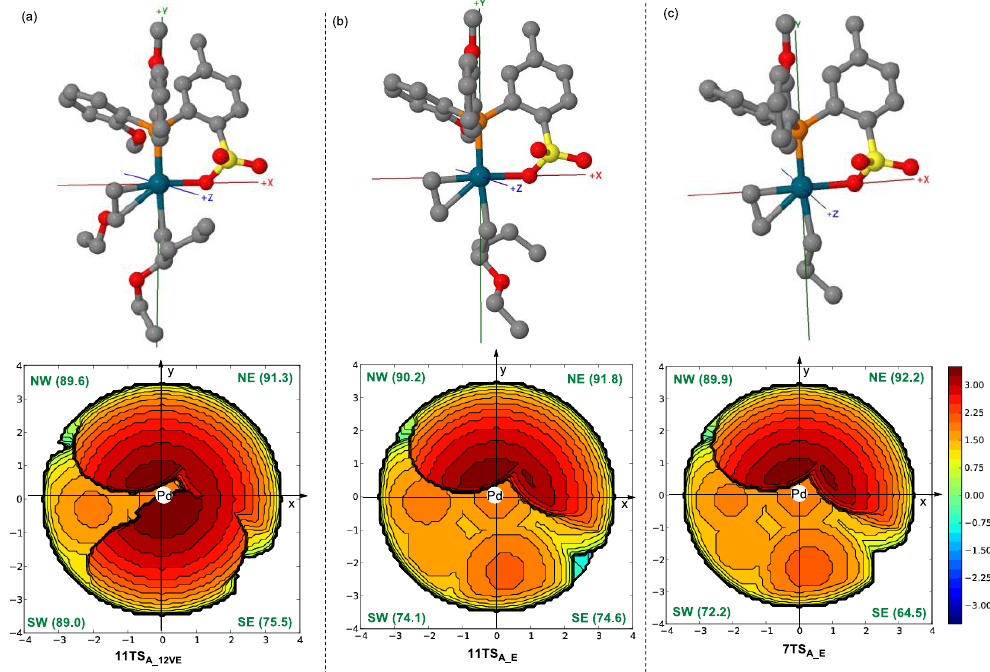
Figure 4. Steric maps for key TSs. ( a ) 11TS A_12VE, ( b ) 11TS A_E , and ( c ) 7TS A_E .